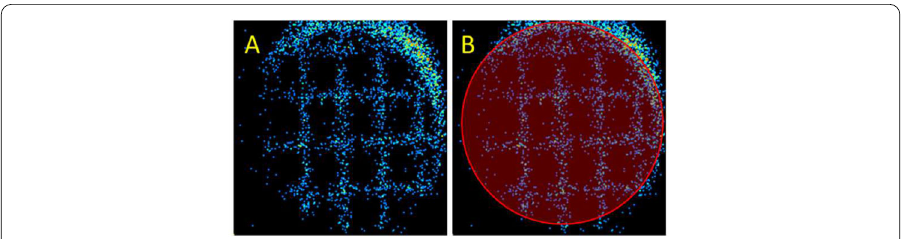
Figure 2 Image of 50-mesh microscopy copper grid obtained by PIXE ( A ) recorded in air at the external microprobe setup and the same image with a mask over-imposed (red circle) delimiting the defined irradiation area ( B ). Grid specifications: 3.05 mm external diameter; pitch 500 μ m; hole 450 μ m; bar 50 μ m )